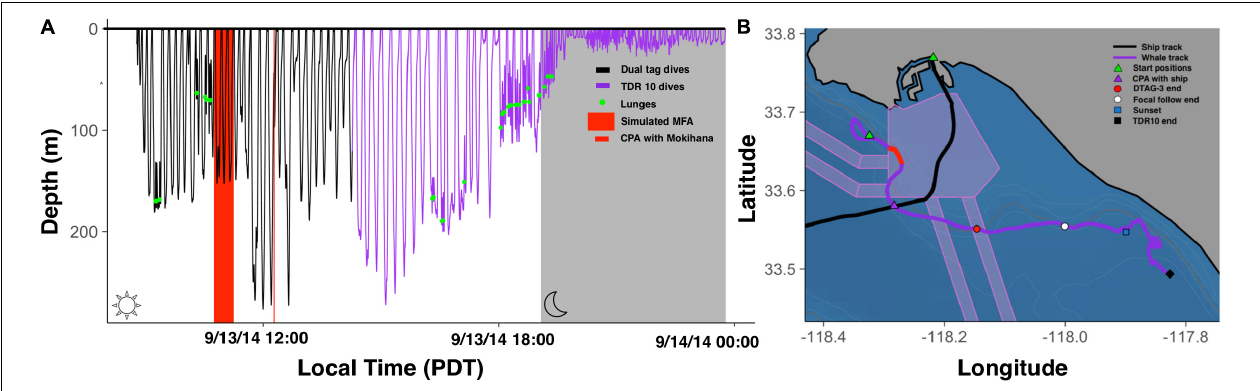
FIGURE 1 | (A) Dive record from DTAG-3 data (black) and TDR10 data (purple). Detected lunges are indicated by green circles. Red shading indicates simulated mid-frequency (3–4 kHz) active sonar playback as part of the SOCAL-BRS CEE. Red line indicates closest CPA with container ship Mokihana. (B) Horizontal tracks of Mokihana (black) and tagged whale (purple). Green triangles represent start positions for ship and whale. Red shading indicates period of the CEE. Purple triangle indicates the whale location during the CPA. Red circle indicates end of DTAG-3 recording, white circle indicates conclusion of focal follow, the blue square indicates sunset, and black square indicates end of TDR10 attachment. Shipping lanes are pink polygons and contour lines are represented in light gray from 50 to 500 m (in 50 m increments), with the 200-m contour in dark